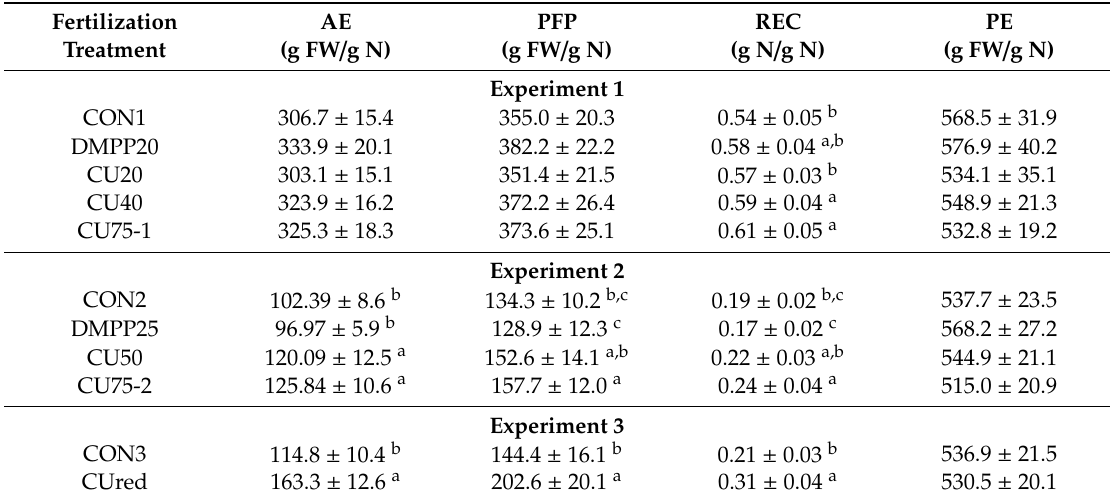
Table 8. Nitrogen use e ffi ciency indexes calculated from the data collected in the three experiments. Fertilization